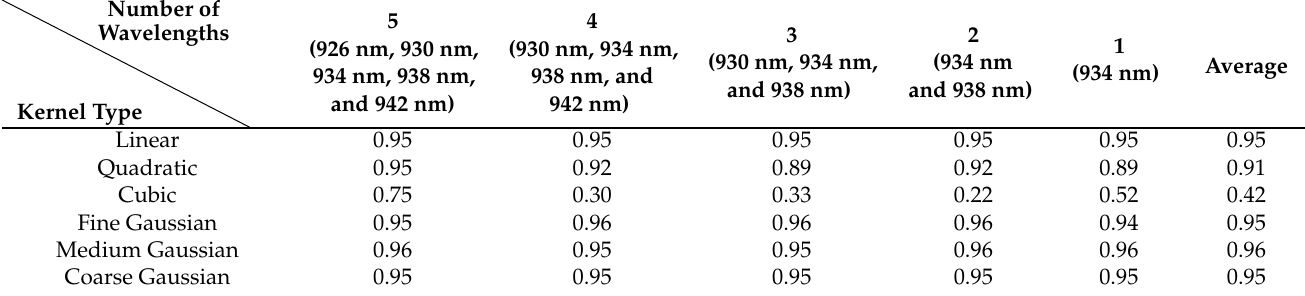
Coarse Gaussian